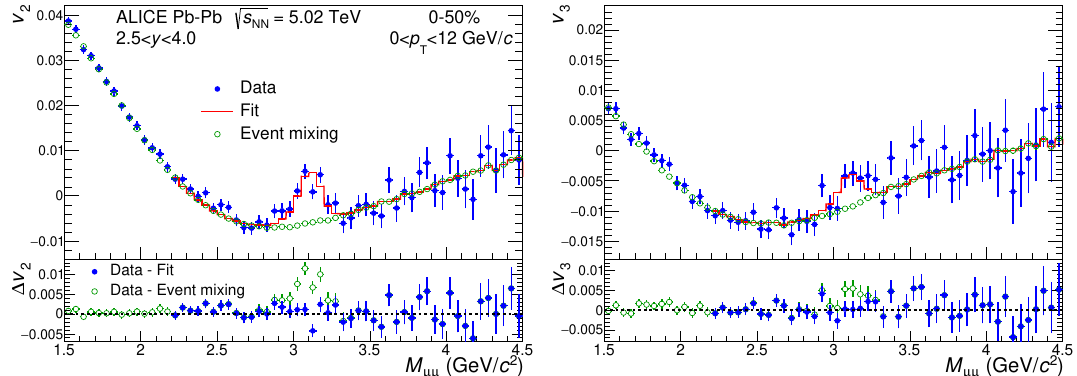
Figure 3 . (Color online) The v 2 ( M (cid:22)(cid:22) ) (left panel) and v 3 ( M (cid:22)(cid:22) ) (right panel) distributions in the 0{50% centrality and 0 < p T < 12 GeV/ c . The distributions are (cid:12)tted with the function from eq. 3.2, where the background coe(cid:14)cients v B mixing procedure. The background coe(cid:14)cients alone down to 1.5 GeV/ c 2 are also presented. Only statistical uncertainties are